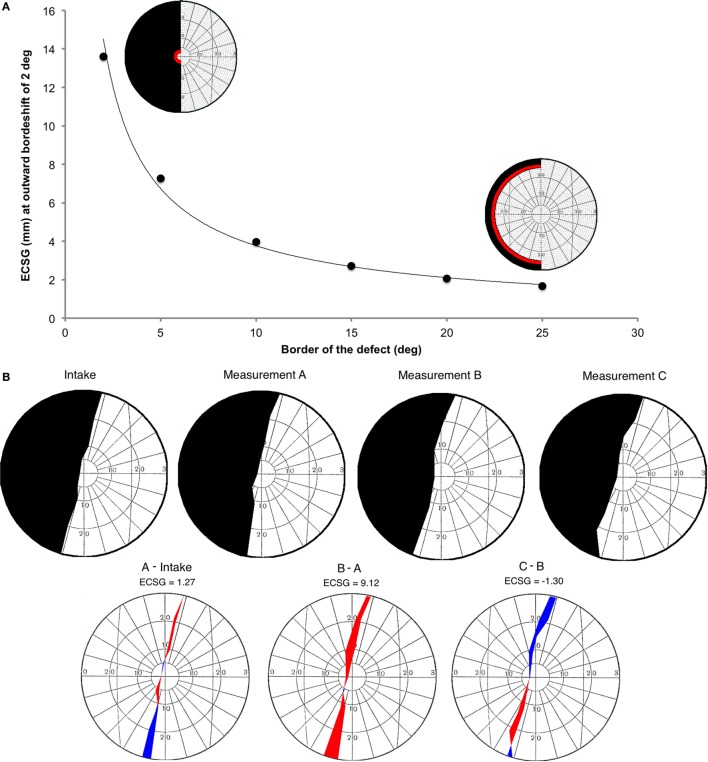
Introduction of a new method to describe visual field changes in terms of equivalent cortical surface gain (ECSG) based on the cortical magnification factor. (A) mm ECSG for 2° of field increase across the entire hemifield, starting at a pre-training defect border of 2°, 5°, 10°, 15°, 20°, and 25° eccentricity. The corresponding area of a 2° field increase (red) is shown for a defect border starting at 2° and 25°, respectively. (B) Goldmann perimetry during intake, prior to training (measurement A), after 40 h of training the affected hemifield (measurement B) and after 40 h training the intact hemifield (measurement C) in one subject (J22). The graphs below show the visual field change, when no intervention was done (A-Intake), for defect training (B-A) and for intact training (C-B). Red represent field increase and blue represent field decrease. The corresponding ECSG values are 1.27, 9.12, and −1.30, respectively. Note that, this patient with right occipital lesion shows a visual field defect crossing the vertical midline. This is reproduced in all four Goldmann measurements and also visible in all three Humphrey measurements.